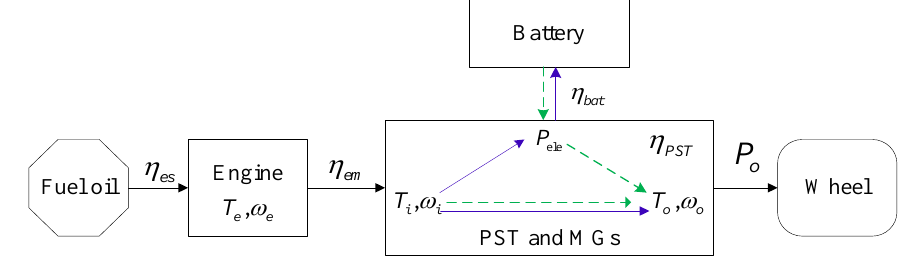
Figure 10. Power flow for the hybrid HDV.